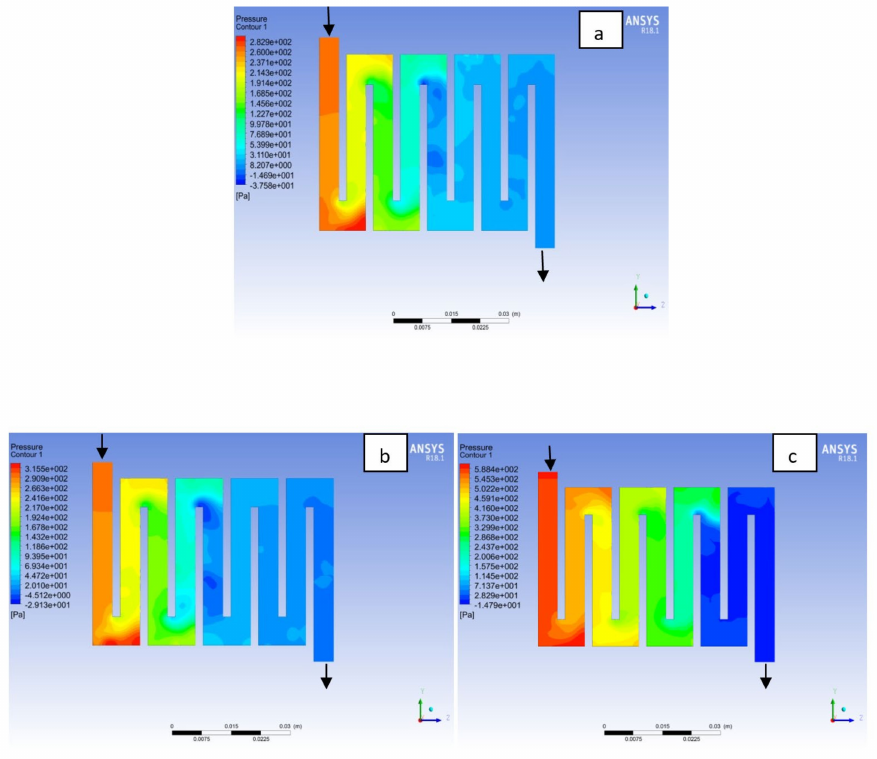
Figure 10. Pressure distribution at the anode region (GDL/CL) for each material with temperature